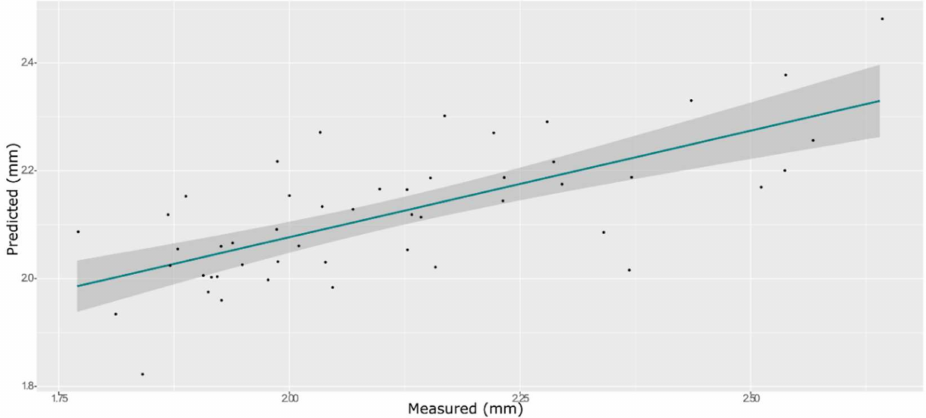
Figure 7. PLS model for BS on the test set, using the selected wavenumbers.